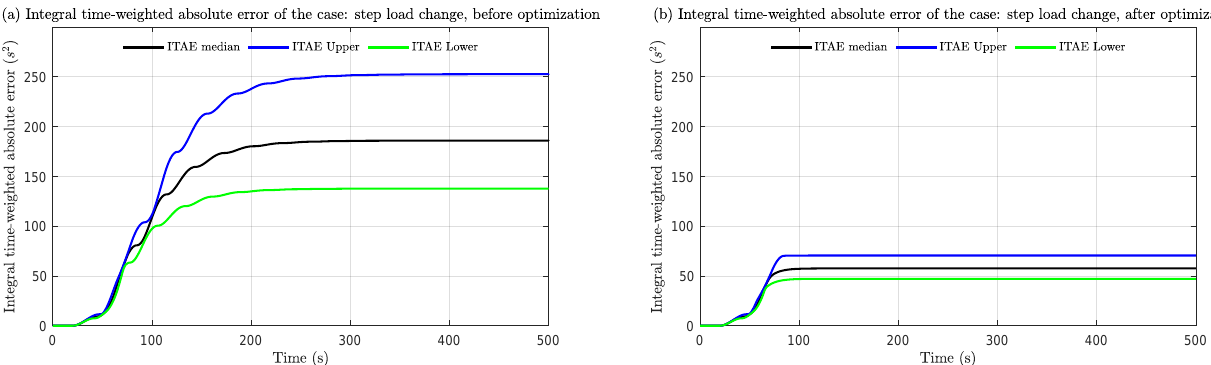
Figure 17. System responses of the case of step load change: ( a ) before optimization; ( b ) after optimization.